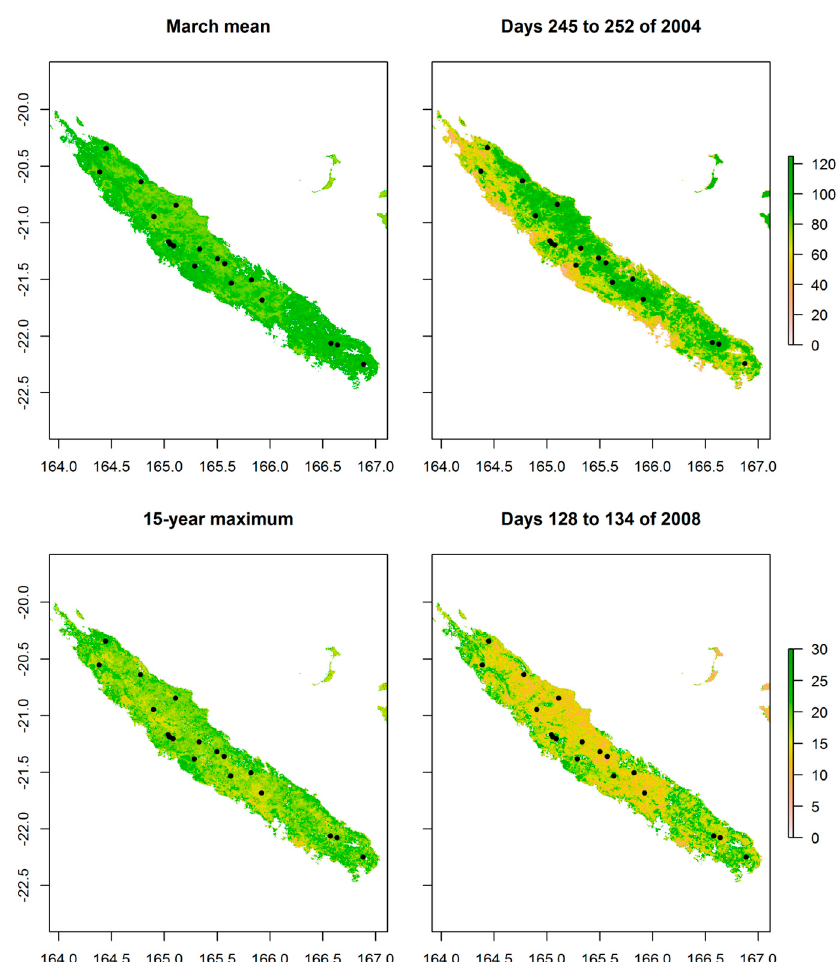
Figure 4. Species richness of trees with dbh ≥ 10 cm (upper line) and 40 cm (lower line) predicted from basic descriptive statistics derived from a 15-year MODIS NDVI time series ( Left Column ) and a single carefully selected scene ( Right Column ) in New Caledonia.